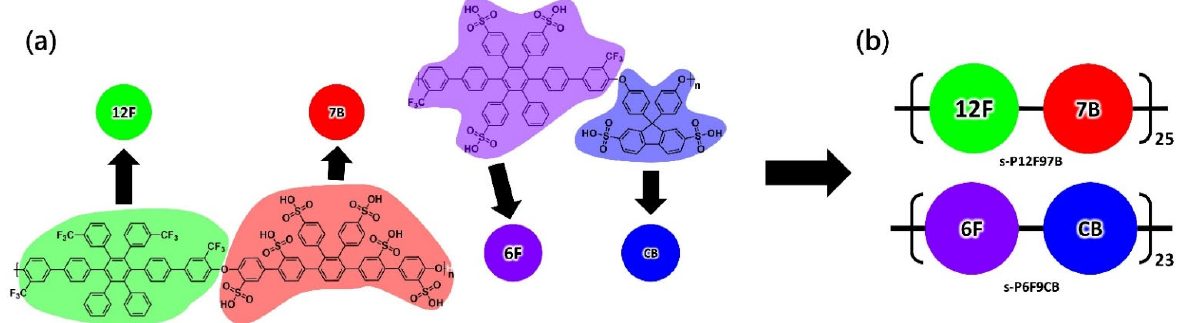
Figure 1. The chemical formula and coarse-grained model of ionomers. The bead chains of selected degree of polymerization and sulfonate graft are shown in ( a ) and ( b ), respectively.